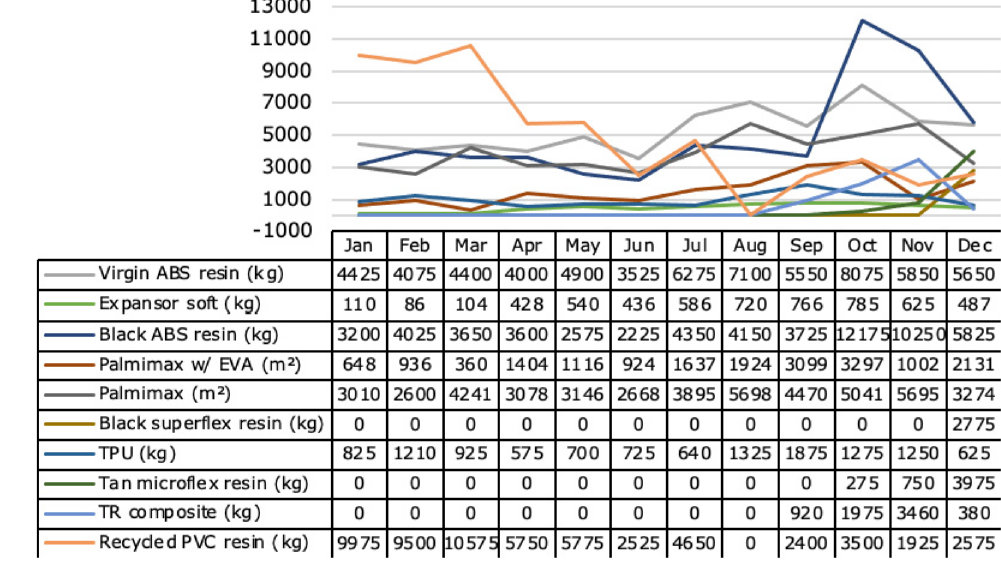
Figure 5. Demand for class A items